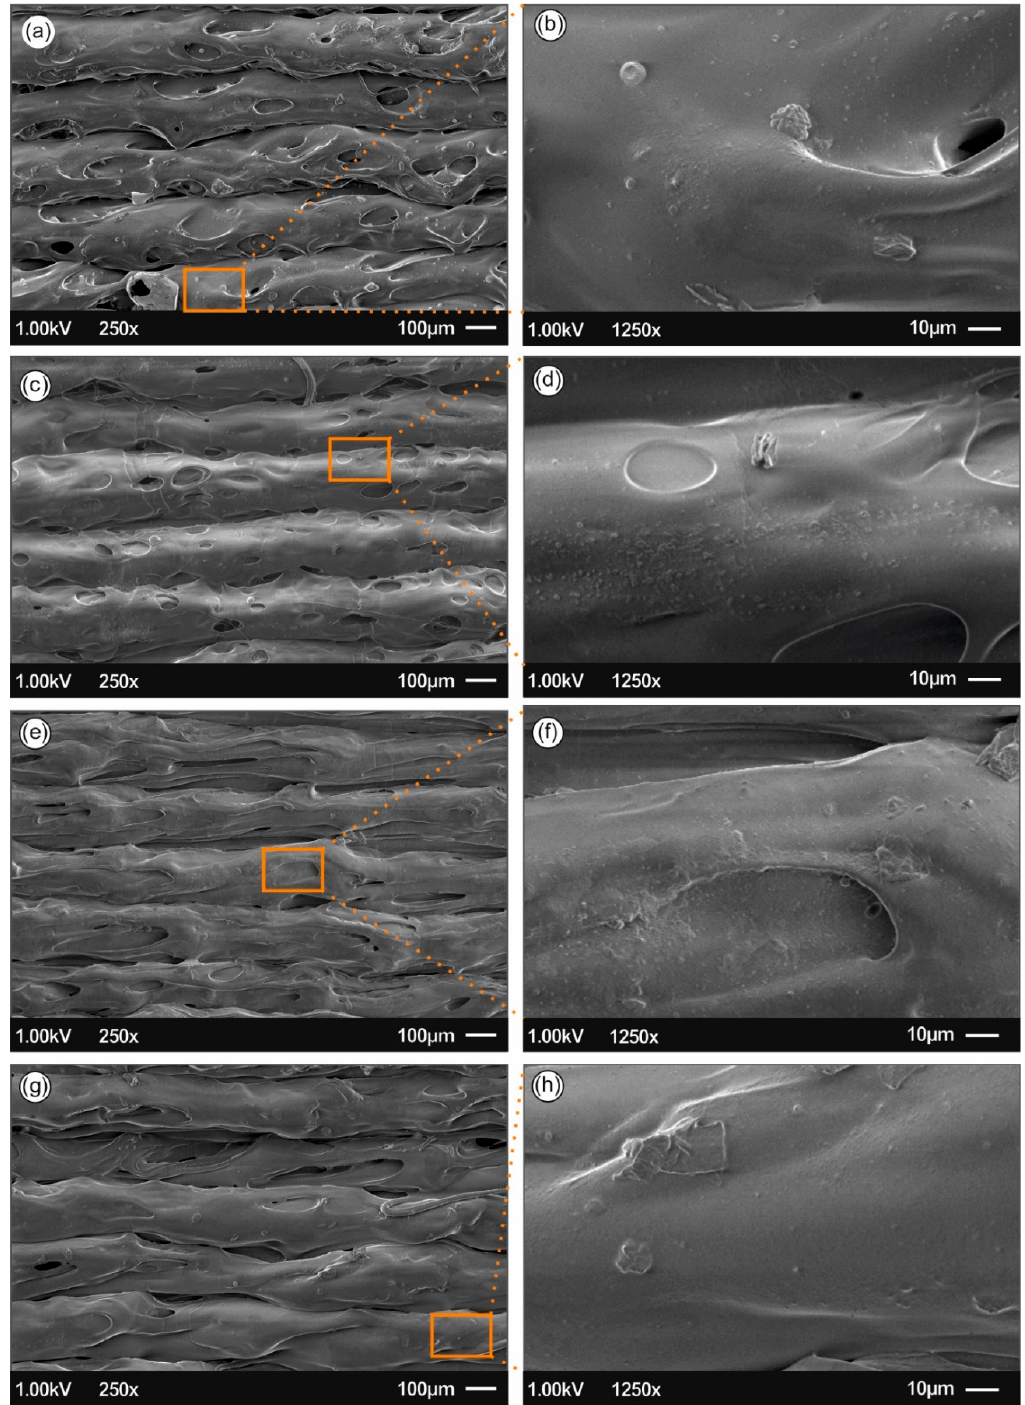
Figure 8. SEM images of the side-surface microstructure and morphology for the different 3D printed samples in this study at two different magnifications (all 3D printed samples with 300 µm printed layer thickness): ( a , b ) PLA/Ag/PEG using rec-01 filament, ( c , d ) PLA/Ag/PEG using rec-02 filament; ( e , f ) PLA/Ag/PVP using rec-03 filament; and ( g , h ) PLA/Ag/PVP using rec-04 filament.